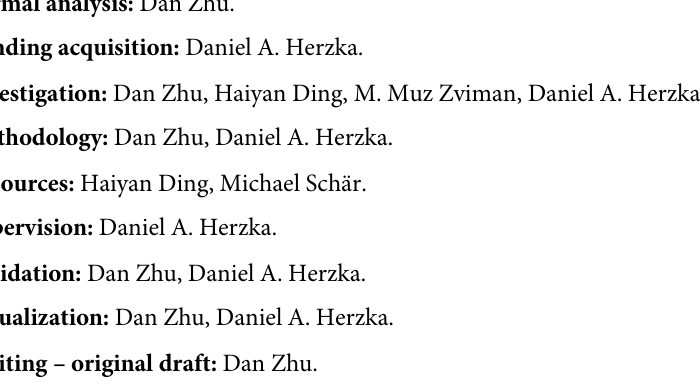
S1 Video. Animation showing all imaging slices in Fig 2. Animation showing all cross-sec- tional slices of the 3D whole-heart dataset described in Fig